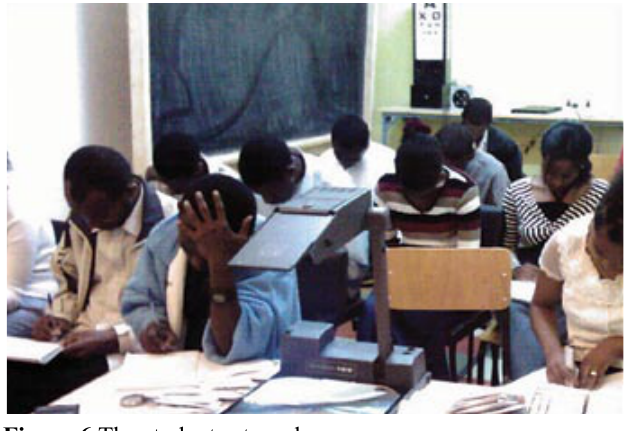
Figure 5 The Department of Optometry